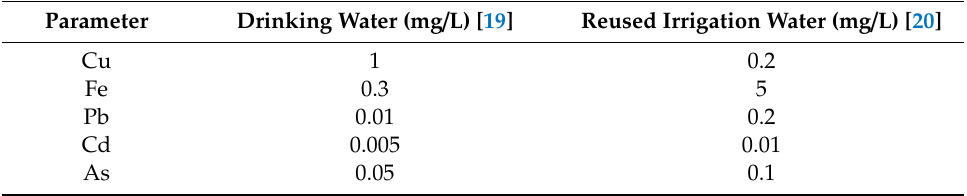
Table 3. PSI drinking water and treated water reused for irrigation standards.